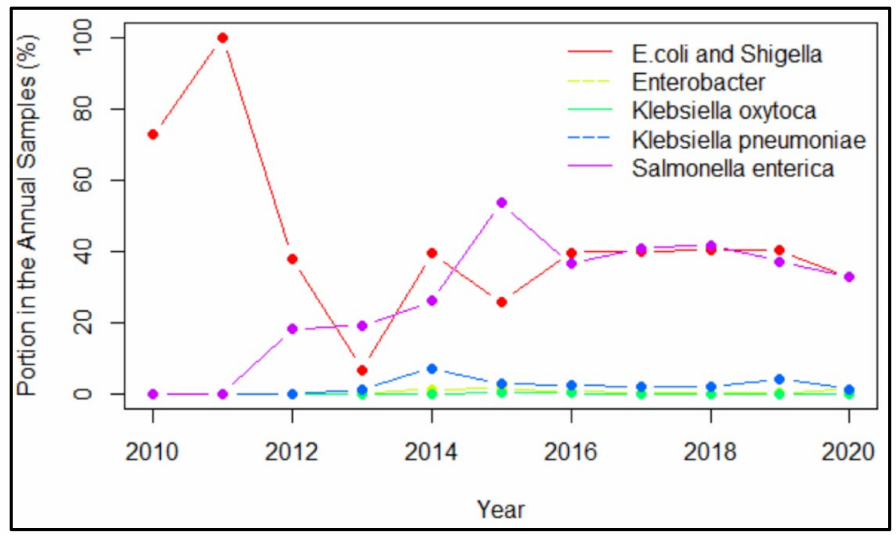
Figure 4. The normalized time profile of important pathogens in the US. Each colored line represents a di ff erent pathogen; generally, their trends flatline after